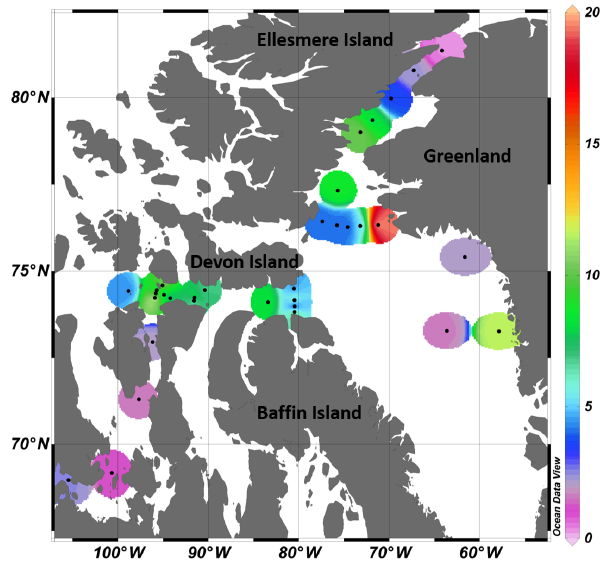
Figure 8. Surface DMS concentrations (nmolL − 1 ) measured at 33 stations across the Canadian Arctic, during July–August